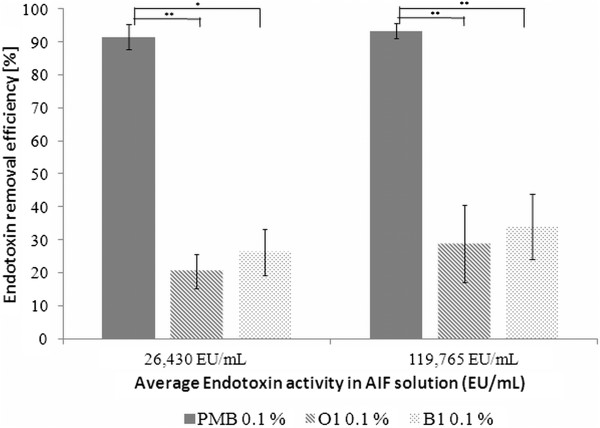
Average of endotoxin binding efficiencies (%) of different sorbents under given conditions (37°C , 2 h incubation) in one endotoxin concentration in AIF. Error bars represent min and max measured deviations of mean binding efficiency. O1 stands for Organoclay 1 and B1 for Bentonite 1. Asterisk show significant differences (P < 0.05) between PMB and used sorbents.